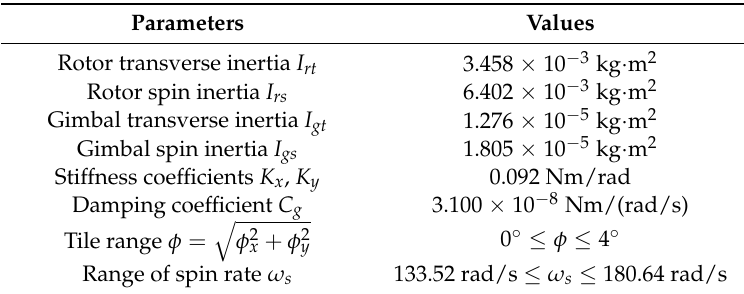
Table 1. Physical parameters of GyroWheel